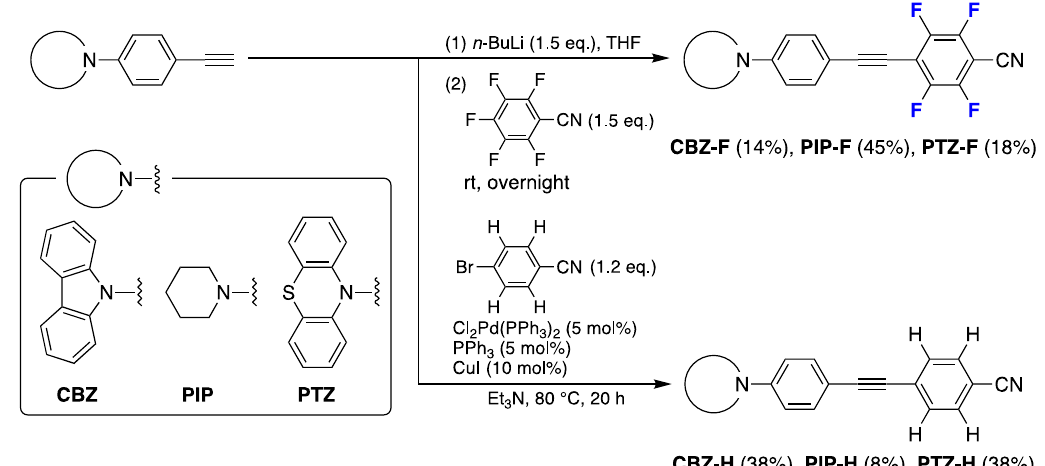
Figure 2. Synthetic procedure for a series of fluorinated and non-fluorinated tolanes with amine-based donors.